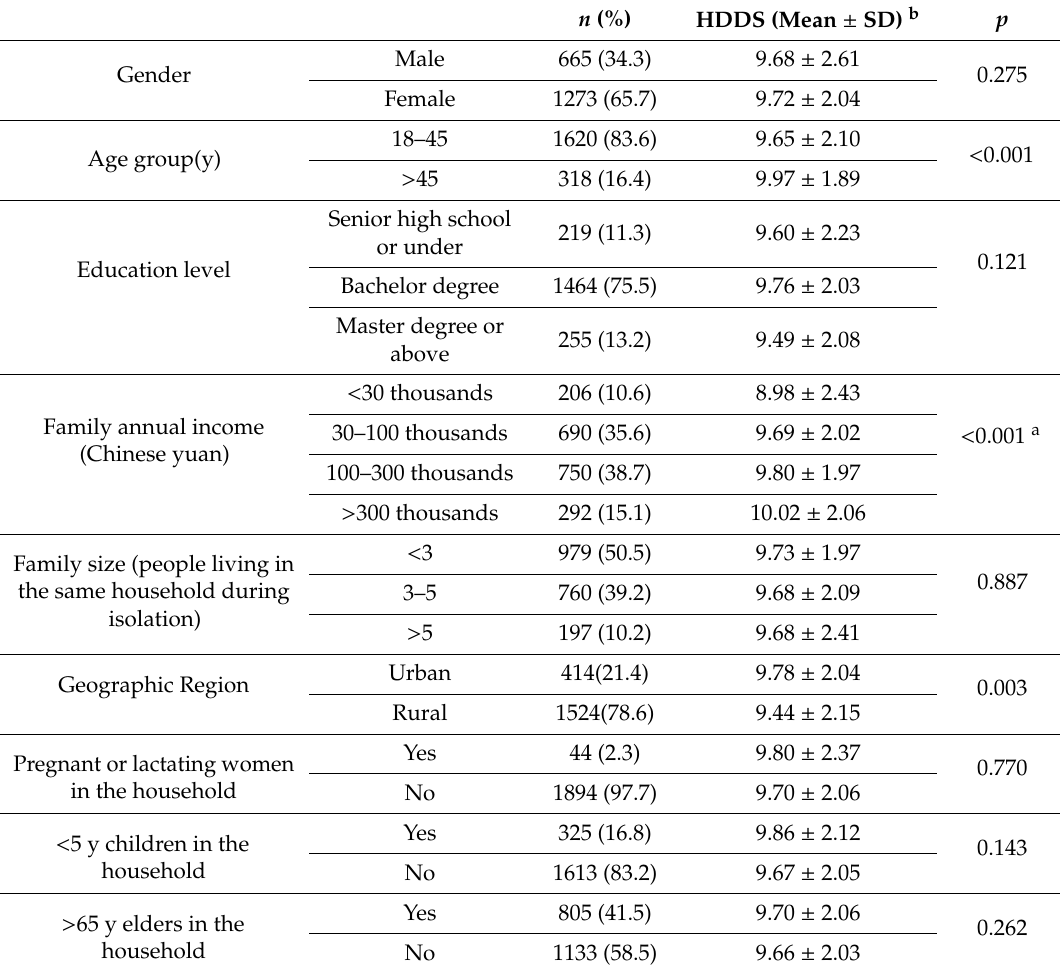
Table 2. Household Dietary Diversity Score (HDDS) among participants with di ff erent socio- demographic characteristics.